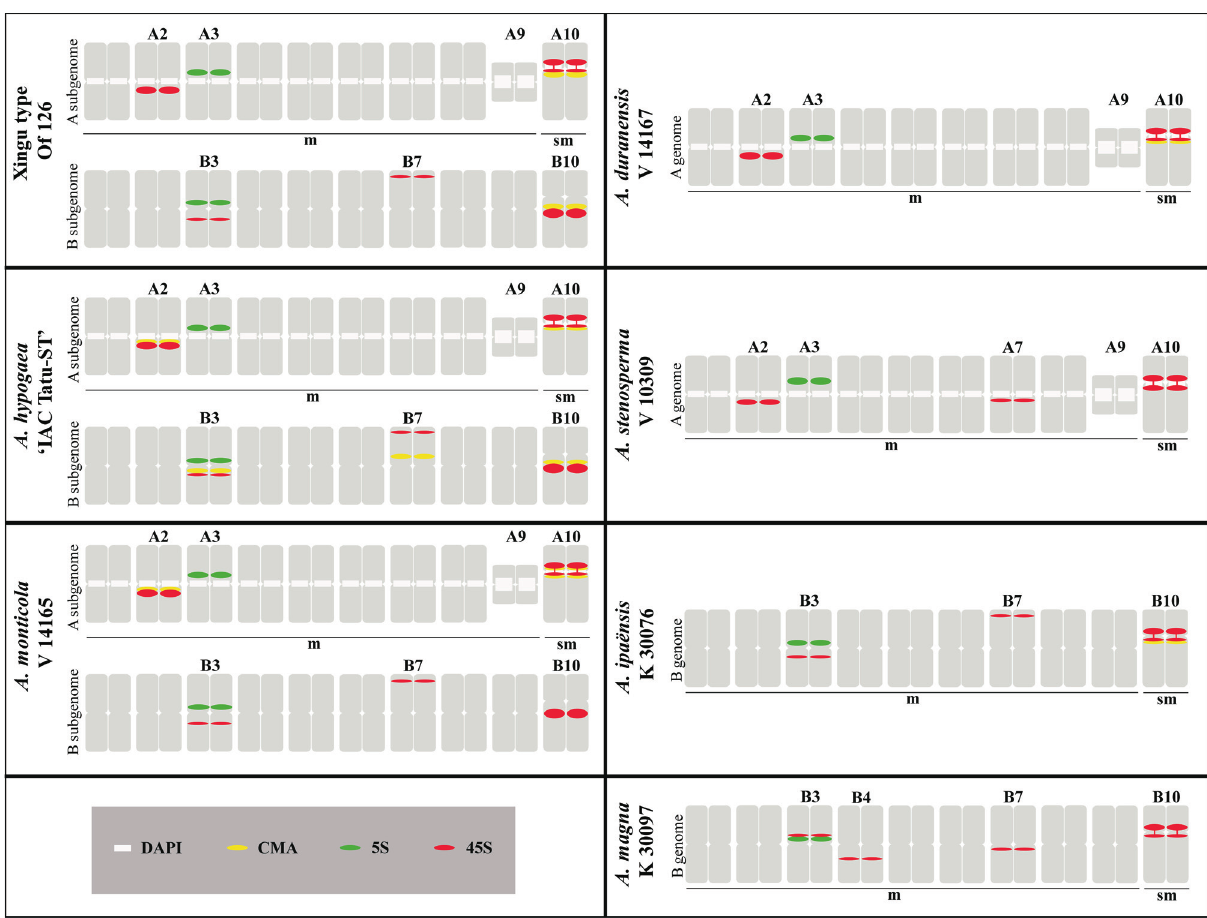
Figure 6 - Schematic diagram of the Arachis karyotypes showing the morphology of chromosomes; position of centromeres (m: metacentric and sm: submetacentric);DAPI + (white)andCMA 3+ (yellow)bandsandrDNAloci,5S(green)and45S(red)inchromosomesofXingutypeOf126; A.hypogaea ‘IAC Tatu-ST’; A. monticola V 14165; A. duranensis V 14167; A. stenosperma V 10309; A. ipaënsis K 30076 and A. magna K